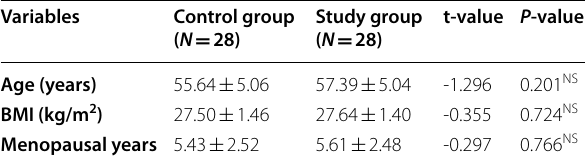
Table 3 Correlation between plasma estradiol level